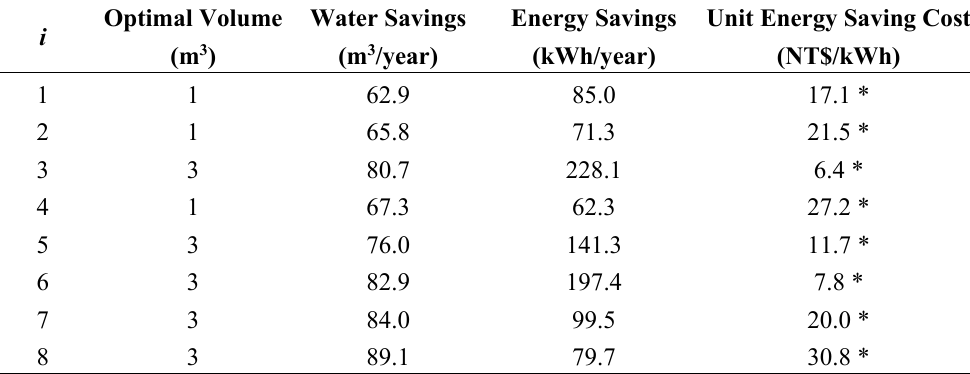
Table 2. The optimal tank volumes and related water-energy saving